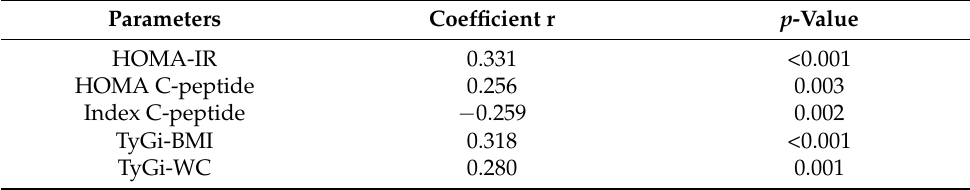
Table 4. Significant correlations between hsCRP and insulin resistance markers.